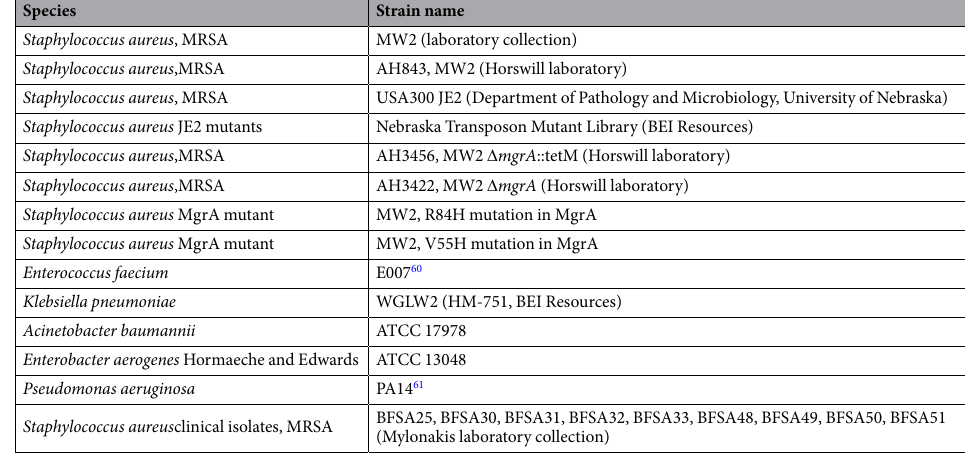
Table 4. Bacterial strains used in this